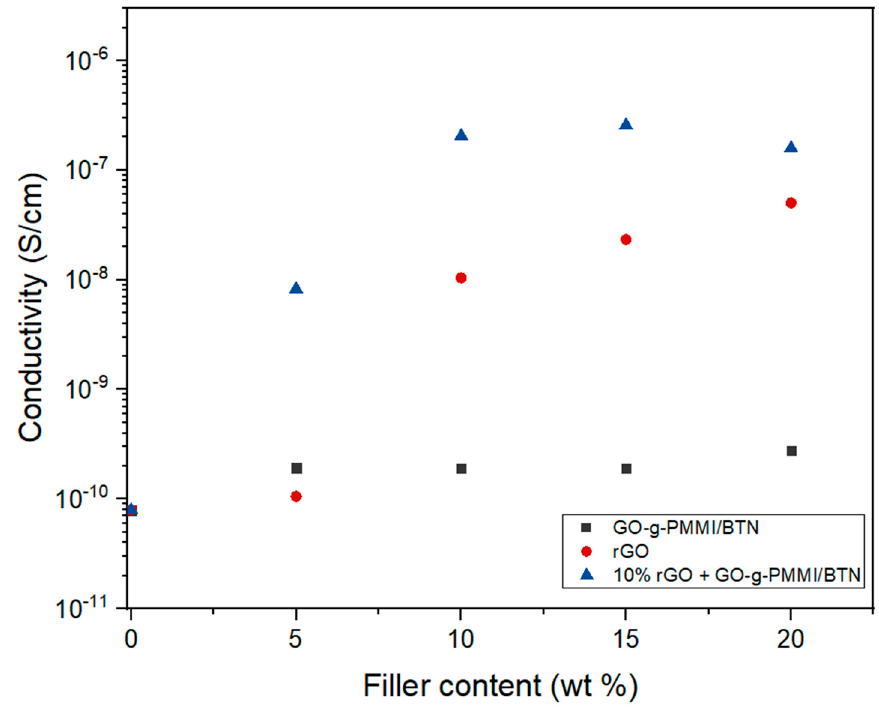
Figure 9. Electrical conductivities of rGO, GO-g-PMMI/BTN and GO-g-PMMI/BTN + 10 wt.% rGO nanocomposites.